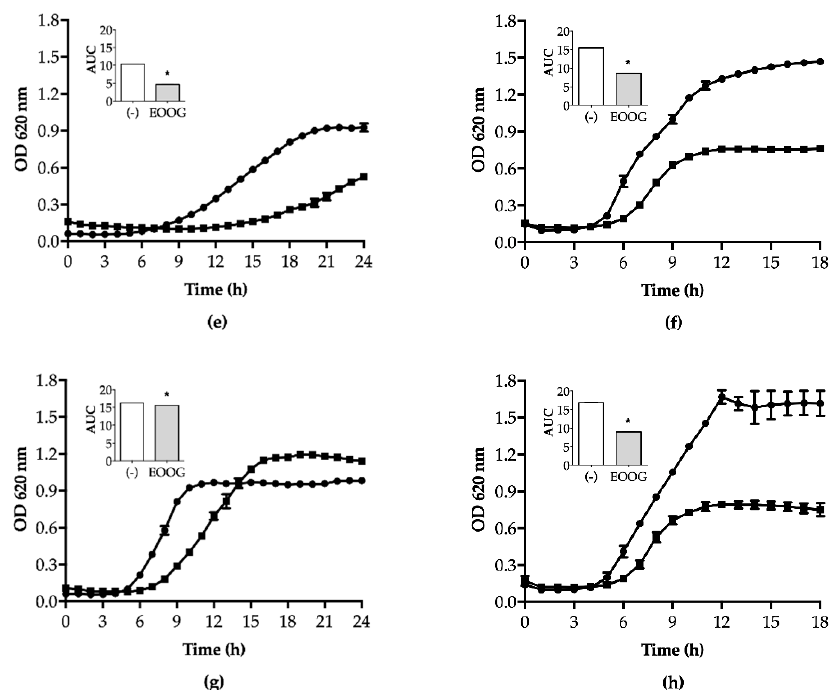
Figure 2. Effect of EOOG (1/2 MIC) on the bacterial growth curve (line graph) of S. aureus ( a ) ATCC 6538, ( c ) 2B, ( e ) 5B, and ( g ) 7B and of E. coli , ( b ) ATCC 11303, ( d ) P12, ( f ) P25, and ( h ) P36. The growth level of the EOOG-treated ( ■ /grey bar) and -untreated ( ● /white bar) cells was quantified by the area under the curve (AUC). * Statistically different by ANOVA ( p < 0.01) compared to the control group.